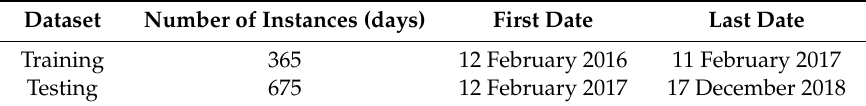
Table 6. Datasets